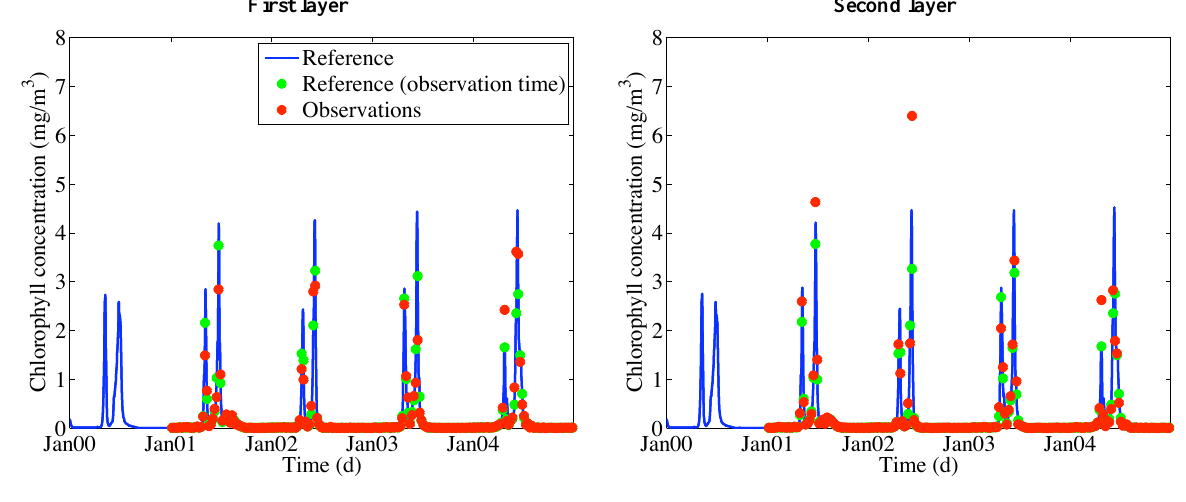
Fig. 2. Time evolution of the chlorophyll concentration at the surface (two first layers) in the reference solution (blue line), in the reference solution at observation times (green circles) and in the observations (red circles) for one